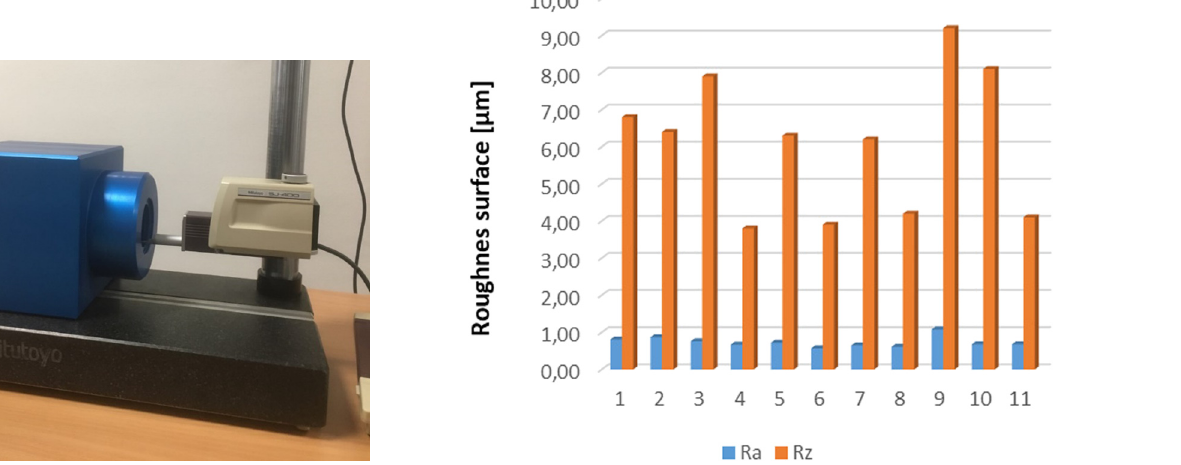
Figure 8: Measurement of the surface roughness of the hole D56H7. Figure 10: Roughness of the hole surface with diameter D72H7.